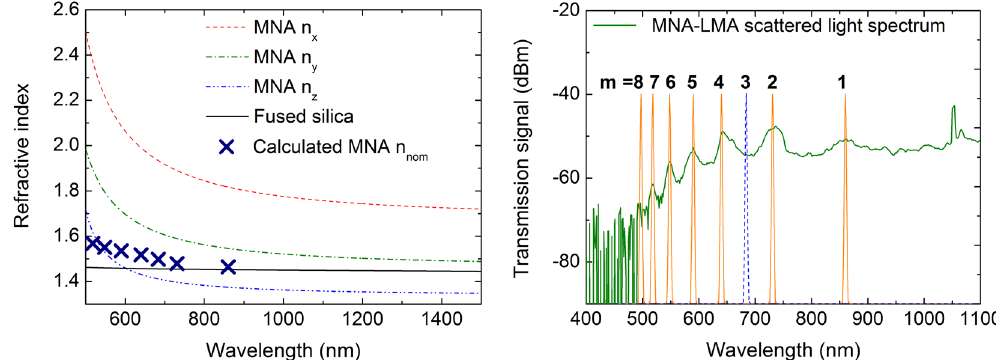
Figure 3. (Left) RI dispersion curves calculated for MNA and fused silica (solid and dashed lines) using Sellmeier coefficients from 20 and 26 , respectively. Calculated nominal MNA RI n nom using equation (1) (‘x’ marks). (Right) Location of composite optical fiber bandgaps from MNA-LMA scattering spectrum and requirement for a sequential λ m order. Peak at modal position m = 3 is plotted as a blue dashed line, as it appears mostly in the transmission spectrum of other MNA-LMA samples (see Figs 4 and 5).